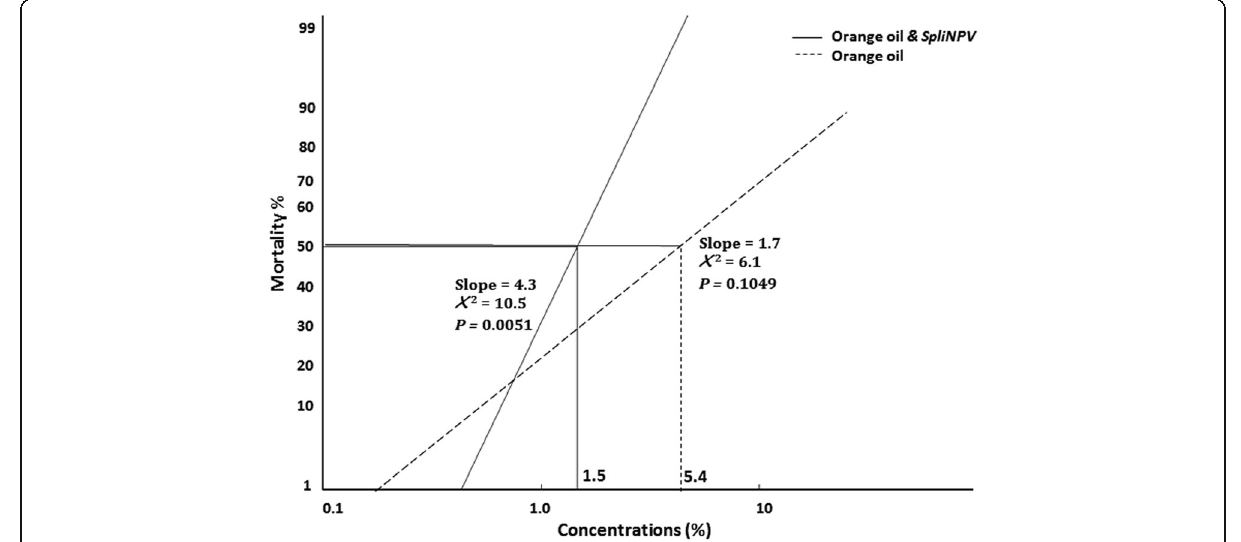
Fig. 4 Effect of Spli NPV on orange oil toxicity against Spodoptera